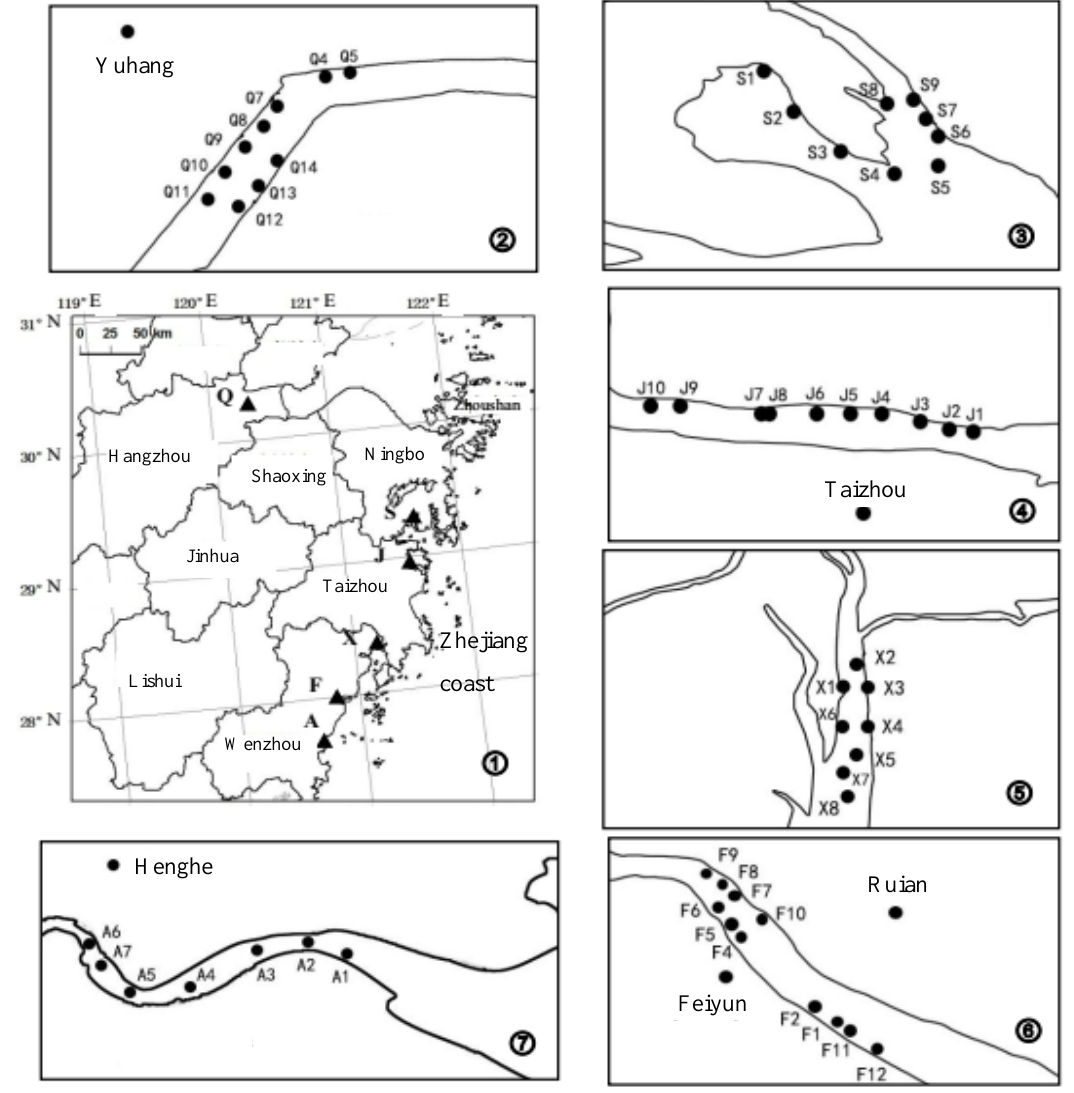
Figure 1. ① Map showing the sampling locations: Qiantang River (Q), Shang River (S), Jiao River (J), Ximen Island (X), Feiyun River (F), Ao River (A); Maps showing the sampling locations along each river magnified: ② Qiantang River, ③ Shuang River, ④ Jiao River, ⑤ Ximen Island, ⑥ Feiyun River and ⑦ Ao River.